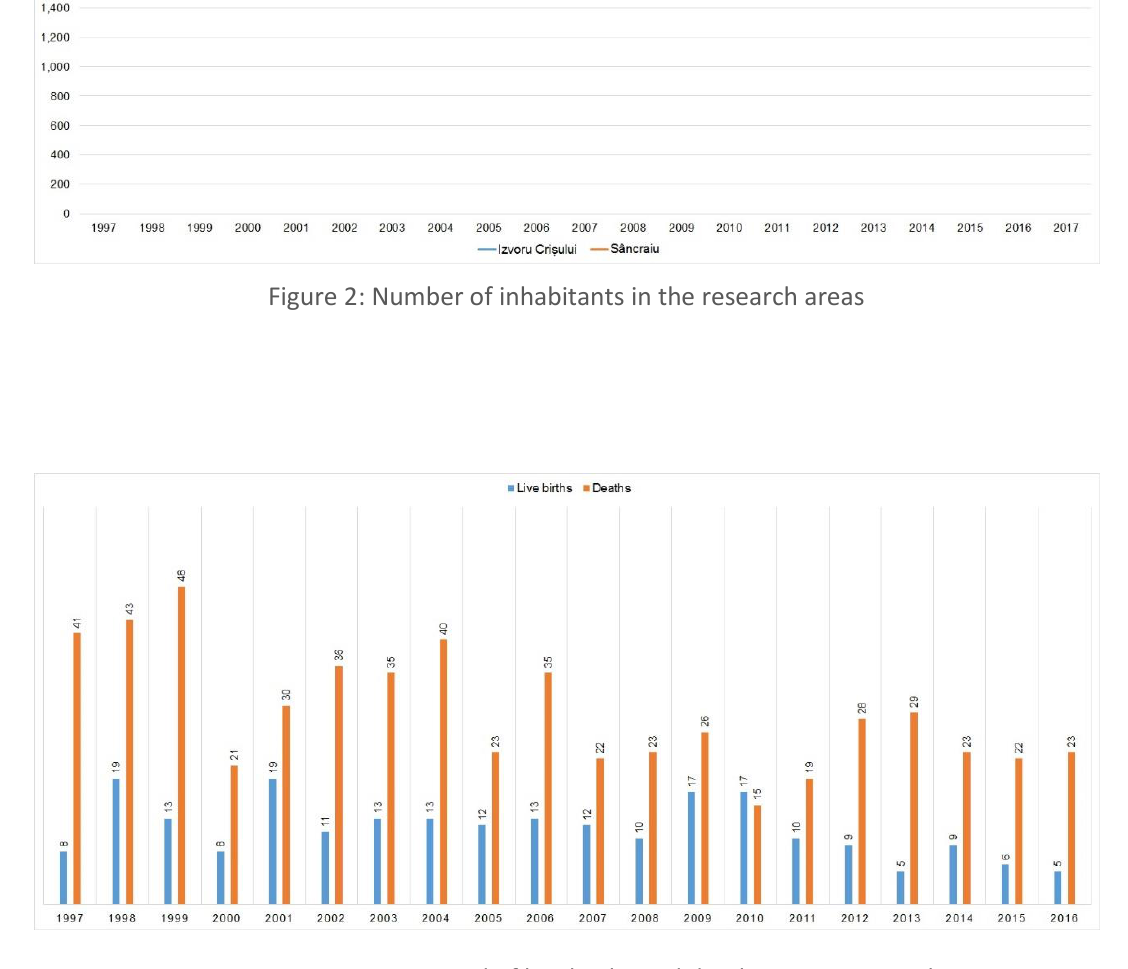
Figure 3: Trend of live births and deaths in Izvoru